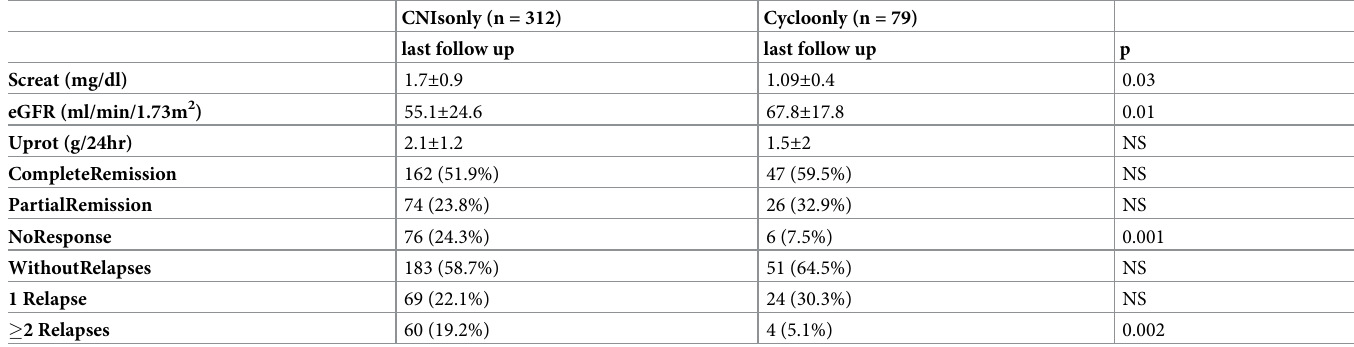
Table 5. Renal function at presentation and outcome of disease in patients who received CNIs or Cyclo based regimes, without second line